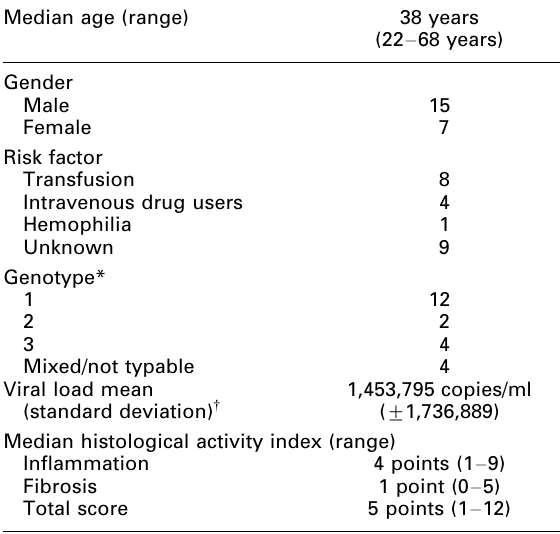
Table 1. HCV patient characteristics